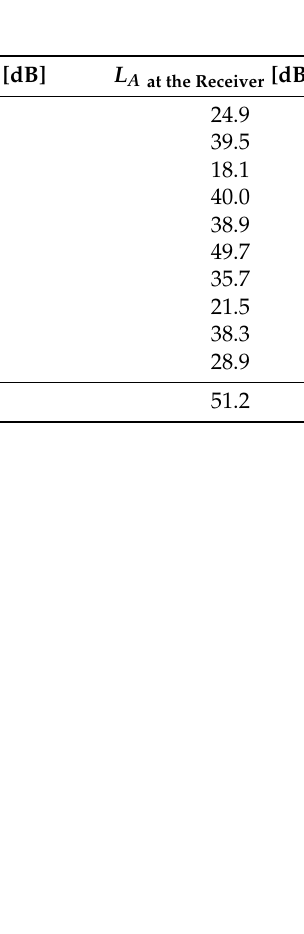
Figure 12. TL of the complete system computed using the TMM.